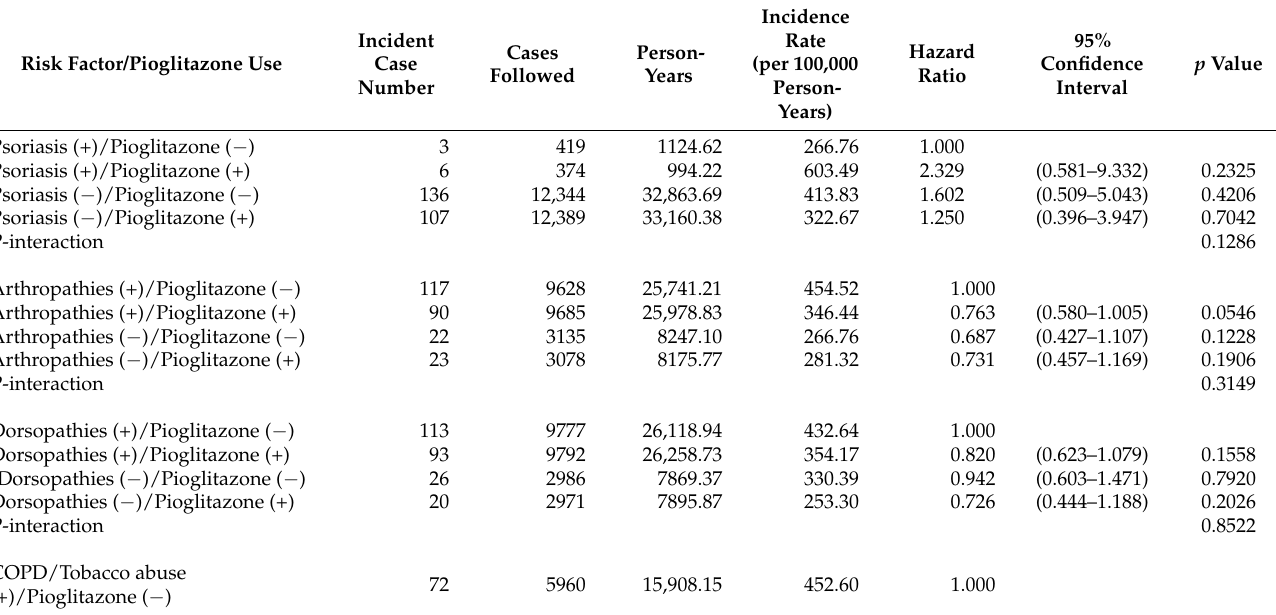
Table 3. Joint effects and interactions between pioglitazone and major risk factors of inflammatory bowel